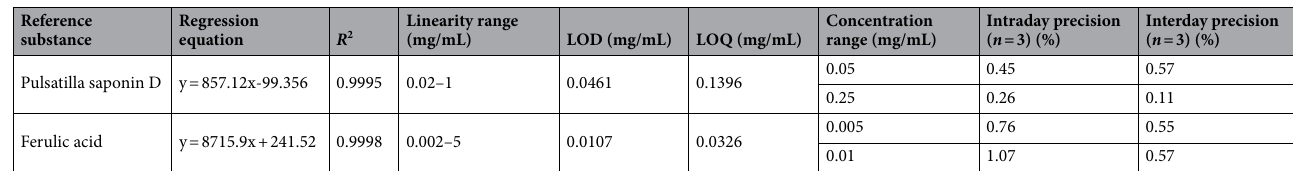
Table 2. Method validation parameters for reference substances; linearity, precision, LOD, LOQ and quantification.